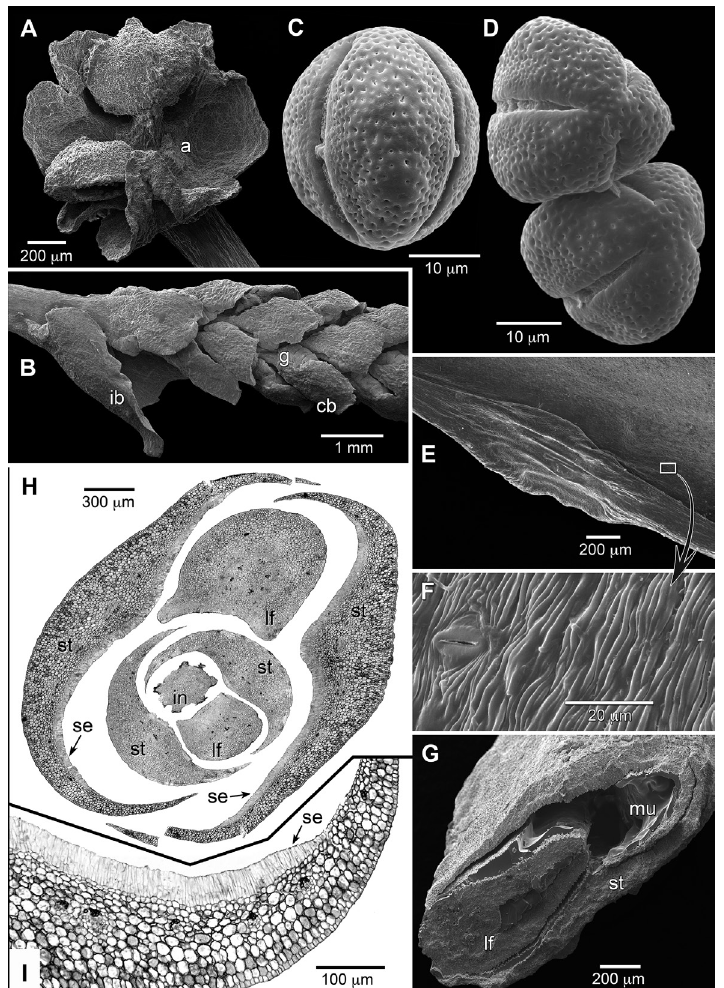
Figure 4. Micromorphological and anatomical features of Incadendron . A Staminate flower with one an- ther removed, showing short filaments and basally connate sepals B Young inflorescence, showing inflo- rescence bract and staminate cymules subtended by glands and bracts C Pollen; mesocolpium-centered equatorial view of whole grain D Pollen; slightly oblique polar view of whole grains E Abaxial laminar sur- face with marginal gland F Abaxial laminar surface closeup, showing striate micro-sculpturing and stomata G Fractured shoot tip, showing stipule surrounding young leaf with conduplicate ptyxis H Anatomical cross section of shoot apex, showing central terminal inflorescence surrounded by nested series of two developing leaves with subtending sheathing stipules (composite tiled image) I Closer view of anatomical cross section of stipule, showing mucilage-secreting cell layer. (Abbreviations: a = site of attachment of missing anther, cb = cymule bract, g = glands, ib = inflorescence bract, in = inflorescence, lf = leaf, mu = dried mucilage, se = secreting cells, st = stipule. A–G imaged with a Zeiss EVO MA15 SEM at 10–12 kV after sputter coating with 25 nm of Au/Pd; SEM samples untreated and directly mounted from dried herbarium specimens; pol- len from dehiscing anthers. H–I from paraffin-embedded, rehydrated herbarium specimens; 7 μm sections stained with iron-mordanted safranin O and celestine blue B; imaged with a Zeiss Universal. Source: